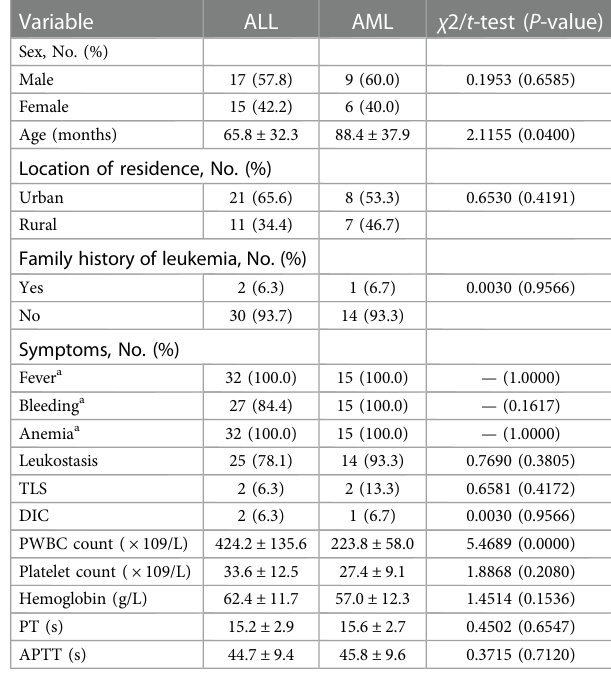
Coagulation also tended to improve with signi fi cant differences between times of PT ( F = 4.26, P = 0.0183) and APTT ( F = 9.82, P = 0.0021). There were no signi fi cant differences between the times of electrolyte detection for Na + ( F = 1.88, P = 0.8310) and Ca 2+ ( F = 1.89, P = 0.1754), but K + ( F = 16.29, P = 0.0002) showed signi fi cant differences ( Table 2 ).